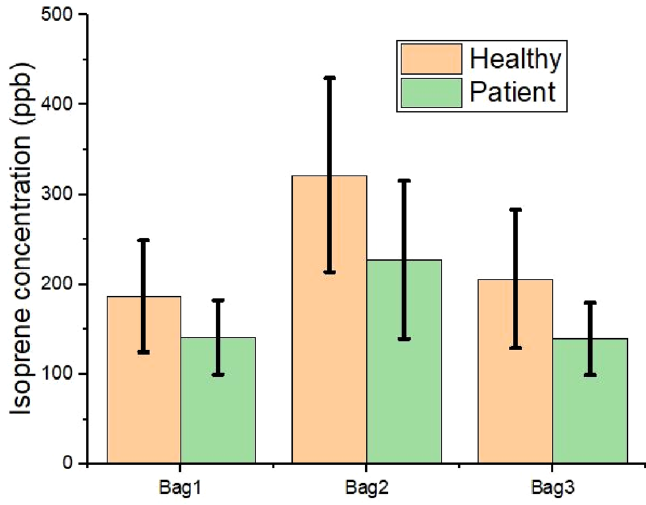
Figure 3. Isoprene concentration (ppb) from collected exhaled breath of patient and healthy group (Bag1: before physical activity, bag2: After physical activity, bag3: after 15 min of